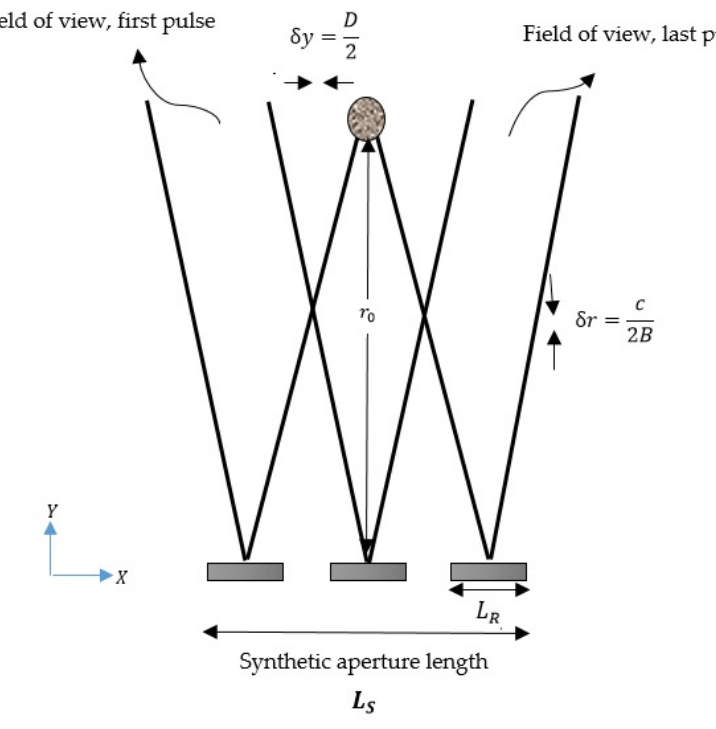
Figure 2. The geometry of a SAS system. The sonar moves along the X-axis and forms a synthetic aperture by transmitting multiple successive pulses to the target scene. By entering until exiting a target in the SAS field of view, it determines synthetic aperture size. Along-track resolution δ y in the range r 0 is given by the transducer element size D alone and is independent of range. δ r, c, and B are the across-track resolution, sound speed in the water, and bandwidth, respectively.